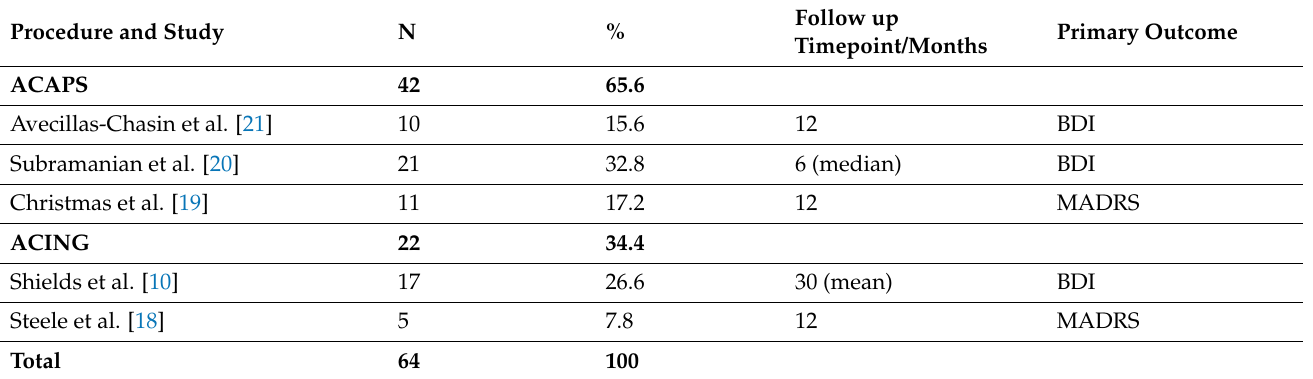
Table 1. Included studies and patients (individual patient data only). N, number of patients; %, proportion of patients included in review. Data in bold represents pooled data from more than one study.